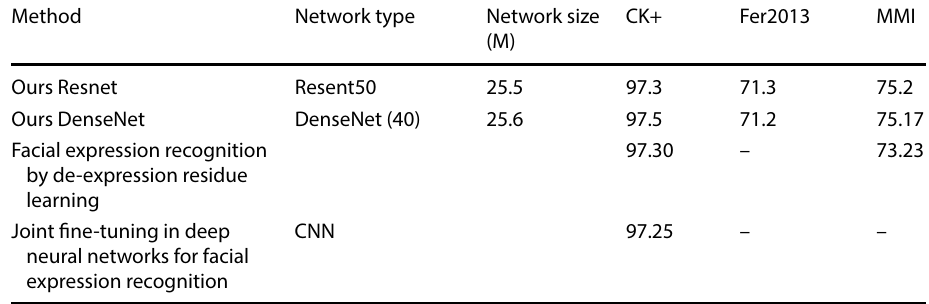
Fig. 6 feature visualization of the last fully connect